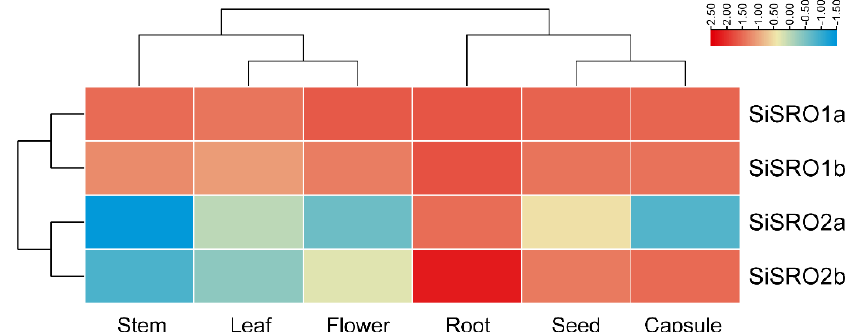
Figure 5. Transcription analysis of the SiSRO genes in different tissues. Log10-transformed RPKM values of each gene were used to construct heatmap. The expression level was shown in color as the scale.